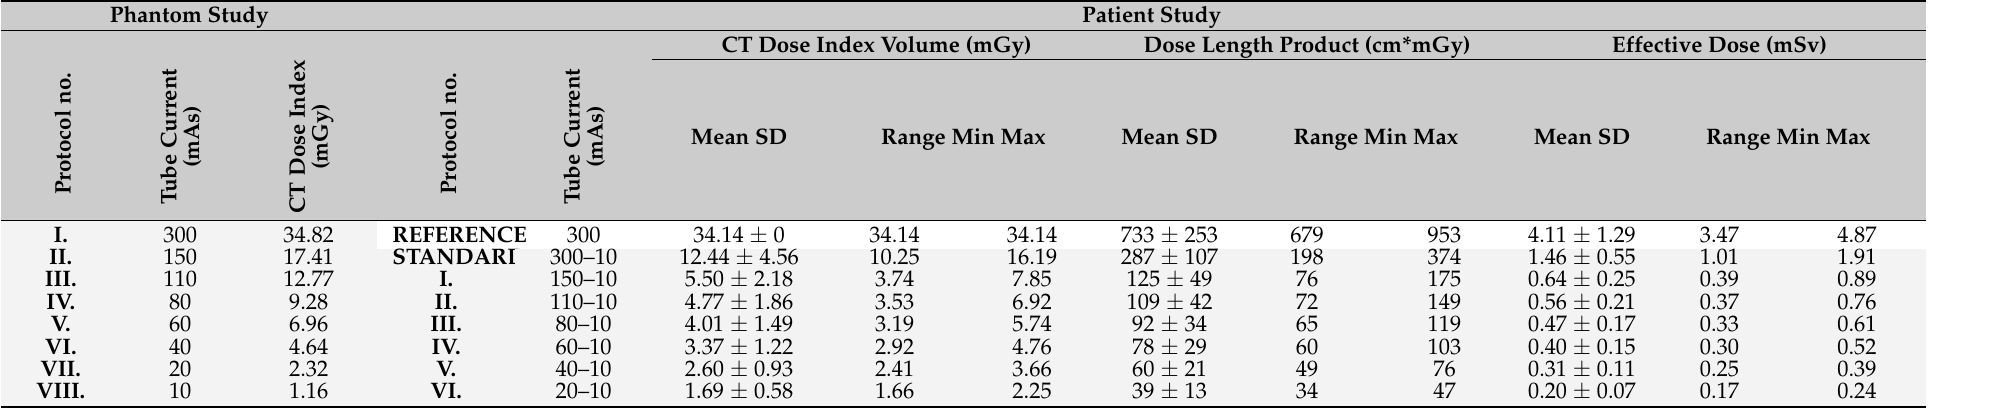
Table 1. Radiation doses of the phantom and patient studies; the mean values ± standard deviations and the ranges of CT dose index, dose length product, and effective dose are given for all scan protocols.